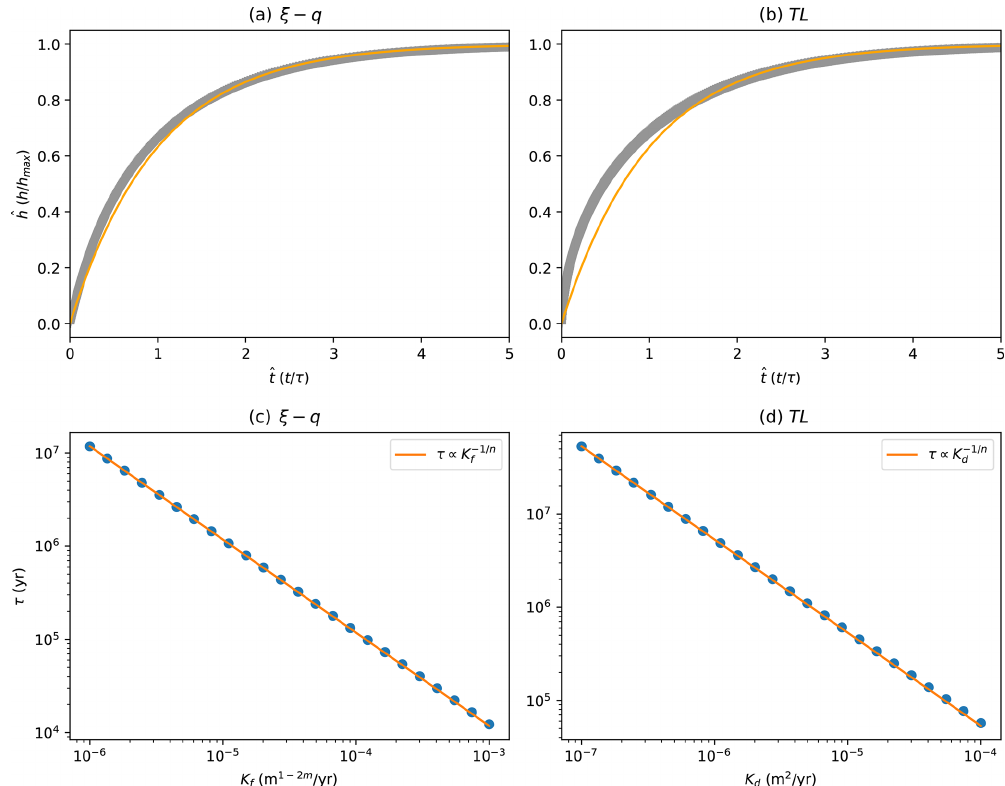
Figure C1. Computed response times for 24 numerical experiments in which the erodibility, K f , or the diffusivity, K d , of the model were varied.